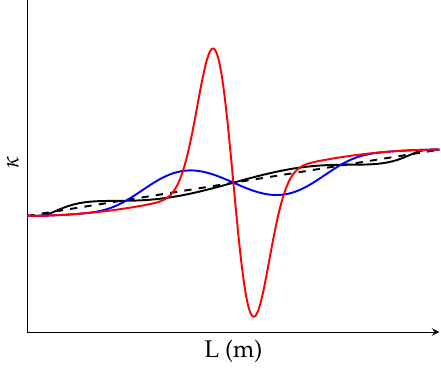
L (m) Figure 20. Curvature plots of the clothoid (dashed) and blending splines in [ p 1 , q 1 ] for slope parameters β = 1.0 (black, default), β = 8.0 (blue), and β = 50.0 (red).